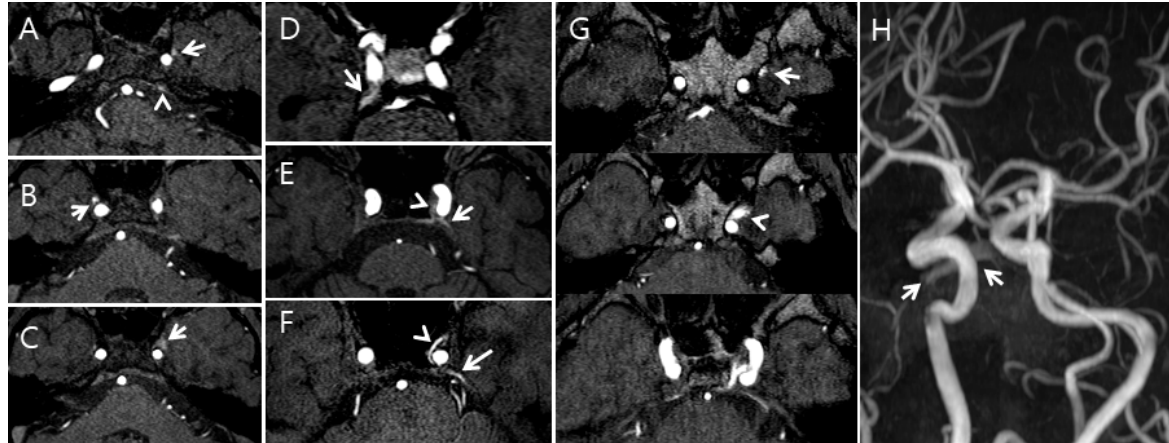
Figure 2. Examples of the five-point grading scale for the cavernous sinus (CS) on time-of-flight magnetic resonance angiography (TOF-MRA); ( A ), Grade I: The left pterygoid sinus flow-related signal intensity (FRSI) (arrow) and left inferior petrosal sinus FRSI (arrowhead) were greater than the signal intensity of the pons on the TOF-MRA source image; ( B ), Grade II: The right pterygoid sinus FRSI (arrow) is equal to that originating from arterial structures of the same size on the TOF-MRA source image; ( C ), Grade III: High signal intensity (arrow) is observed in less than or equal to one-third of the CS and pterygoid plexus on the TOF-MRA source image; ( D ), Grade II: The right superior petrosal sinus FRSI (arrow) is equal to that originating from arterial structures of the same size on the TOF-MRA source image; ( E ), Grade III: A high signal intensity (arrowhead) is seen in less than or equal to one-third of the CS, and the left superior petrosal plexus (arrow) is seen on the TOF-MRA source image; ( F ), Grade IV: A high signal intensity (arrowhead) is seen in more than one-third of the CS, and the superior petrosal plexus (arrow) is seen on the maximum intensity projection source image; ( G , H ), Grade IV: A high signal intensity (arrowhead) in more than one-third of the CS and pterygoid plexus (arrow) is seen on the maximum intensity projection source image ( G ). A high signal intensity (arrows) was seen in the pterygoid plexus on the TOF-MRA maximum intensity projection image ( H ).